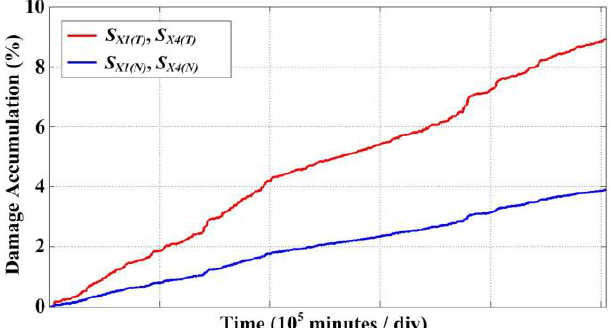
Figure 13. Damage accumulation (DA) of the outer IGBTs of the NPC inverter and the half-bridge IGBTs of the T-type inverter during the mission profile.